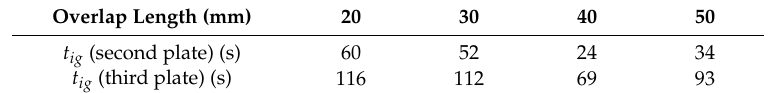
Table 6. Ignition times of the second and third PMMA plate under di ff erent experimental conditions. Overlap Length (mm)